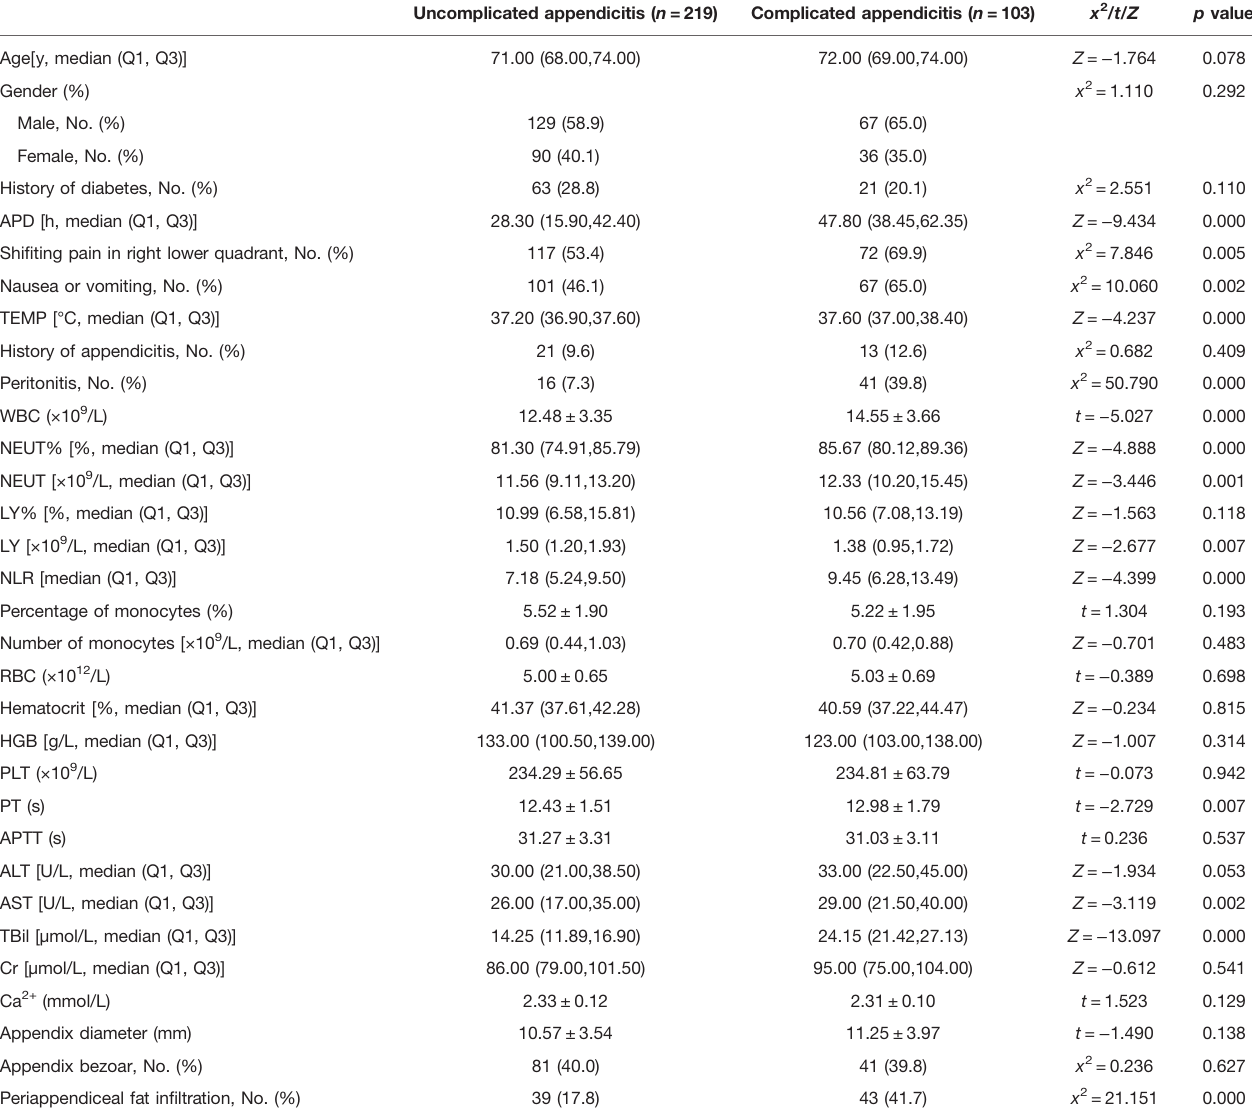
TABLE 1 | Baseline characteristics of patients undergoing appendectomy.